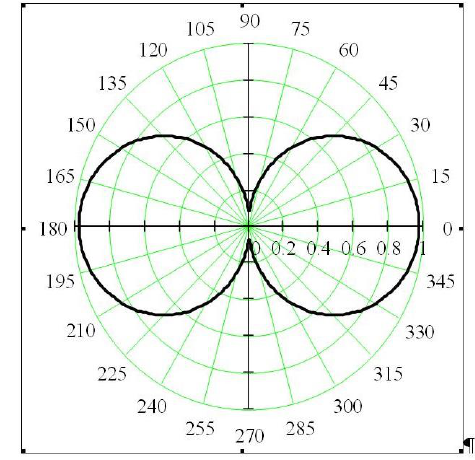
Fig. 8. Transmittance coefficient |S 21 | through THz polarizer based on the resonance metasurface of single rectangular graphene strip in the unit cell on the dielectric substrate depending on the angle φ of orientation of the electric field E of incident TEM -wave respective to graphene strip: f= 28.7 THz ; μ с = 0.57 eV; a = 2 μ m, b = 0.2 μ m, w = 0.1 μ m, l/a = 0.9, h = 0.5 μ m, ε =